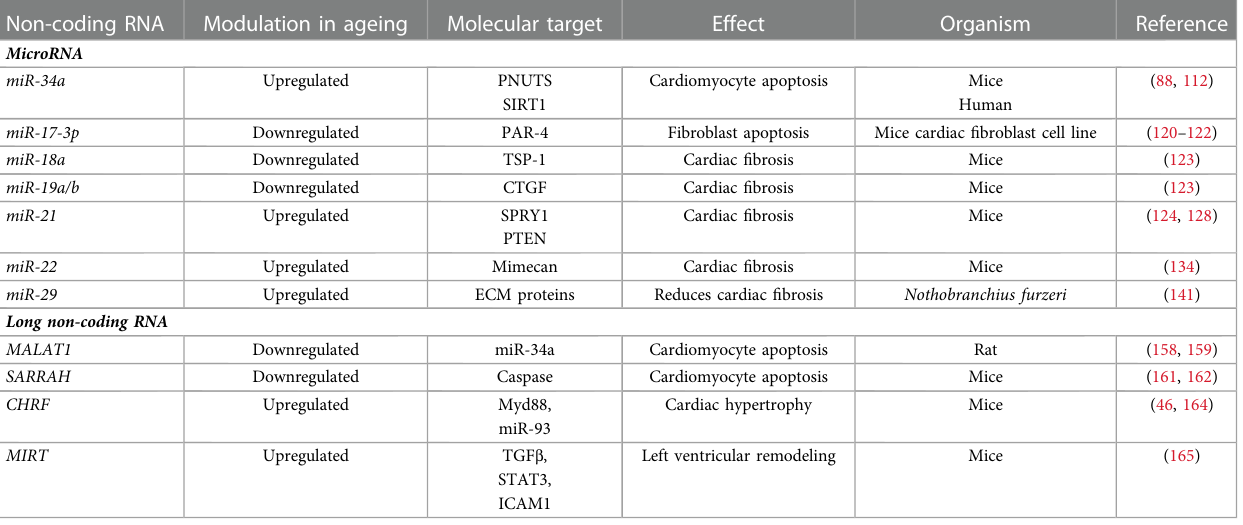
TABLE 1 Non-coding RNAs associated with cardiac ageing.